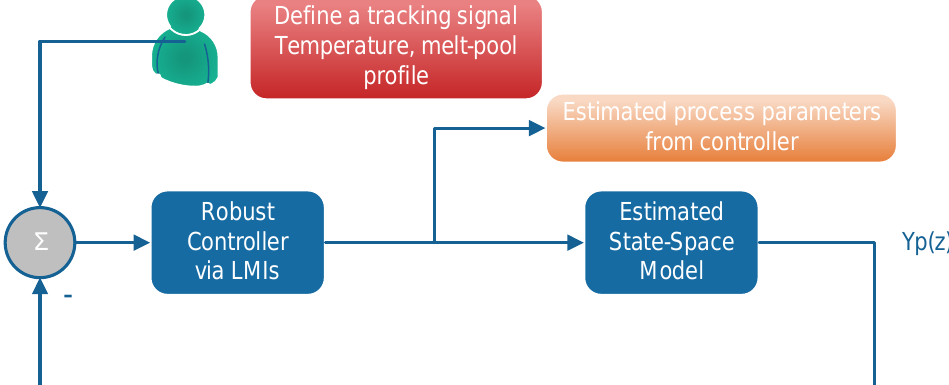
Figure 7. Closed-loop